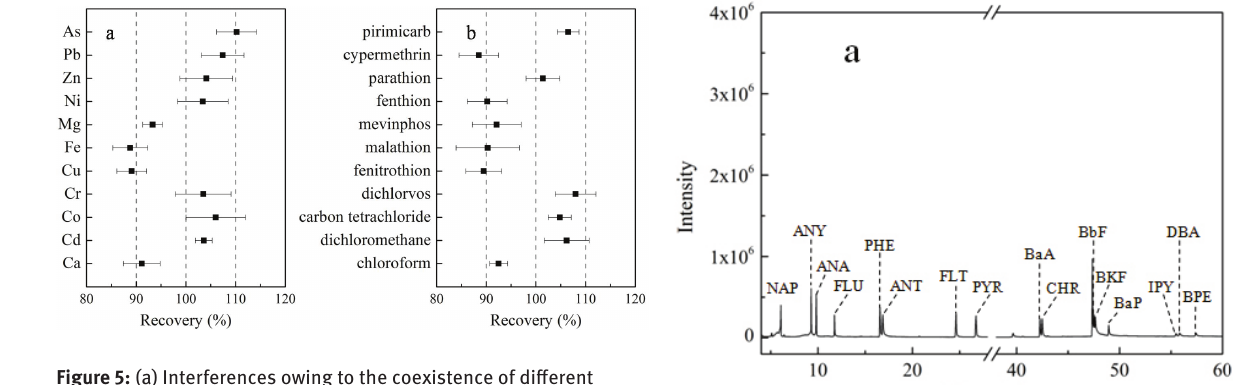
Figure 5: (a) Interferences owing to the coexistence of different inorganic ions at a concentration of 100 µg mL -1 . (b) Interferences owing to the coexistence of different organic materials at a concentration of 100 µg mL -1 .